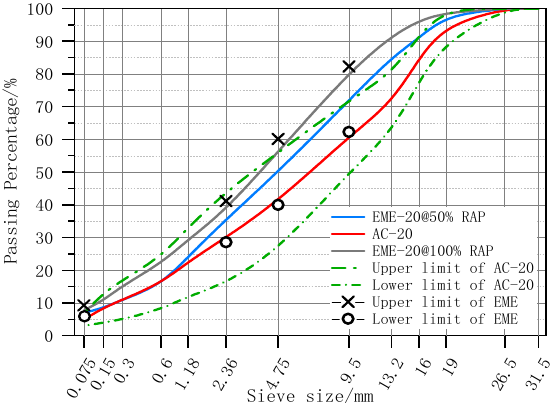
Figure 1. The aggregate gradation of the three designed mixtures.